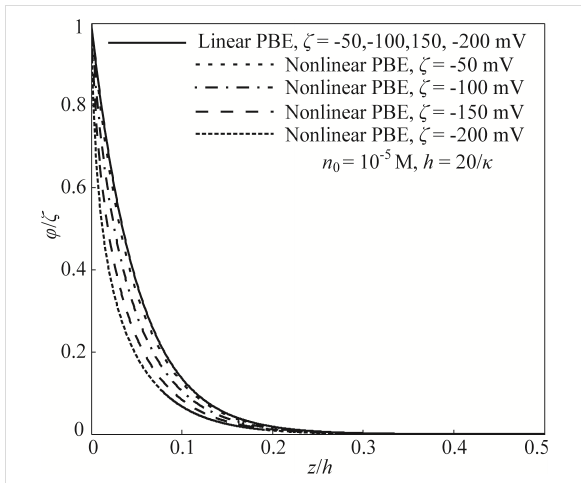
Figure 2: Dimensionless electrical potential distribution obtained by solving the linear PBE and the nonlinear PBE (the model used in present work).